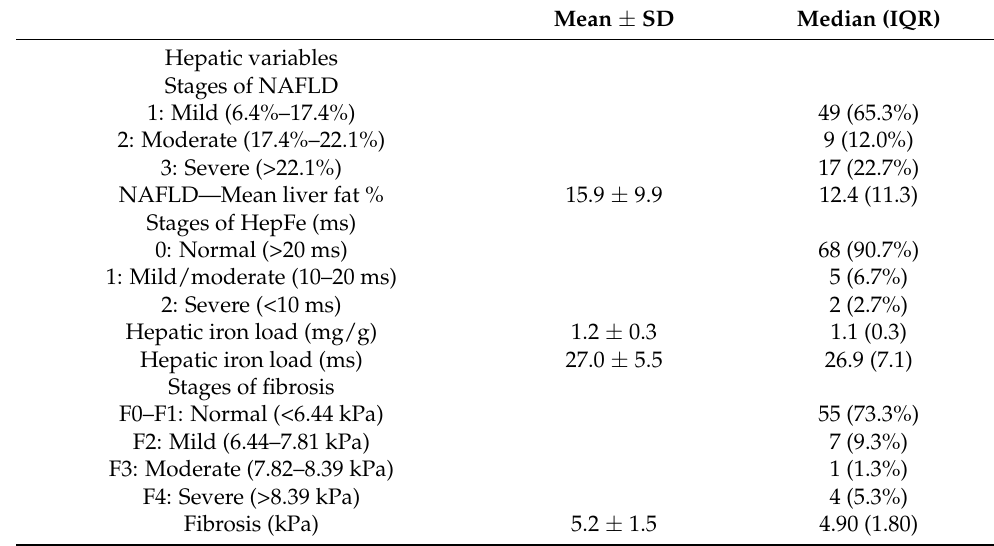
Table 3. Hepatic and renal characteristics of the current study population ( n =